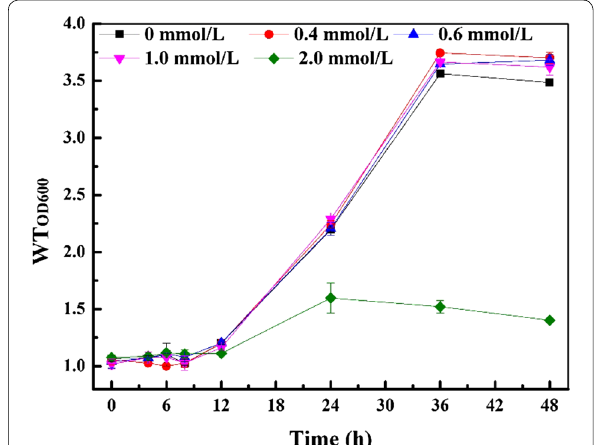
Fig. 4 Influence of different Cu 2 + concentrations on the growth of WT